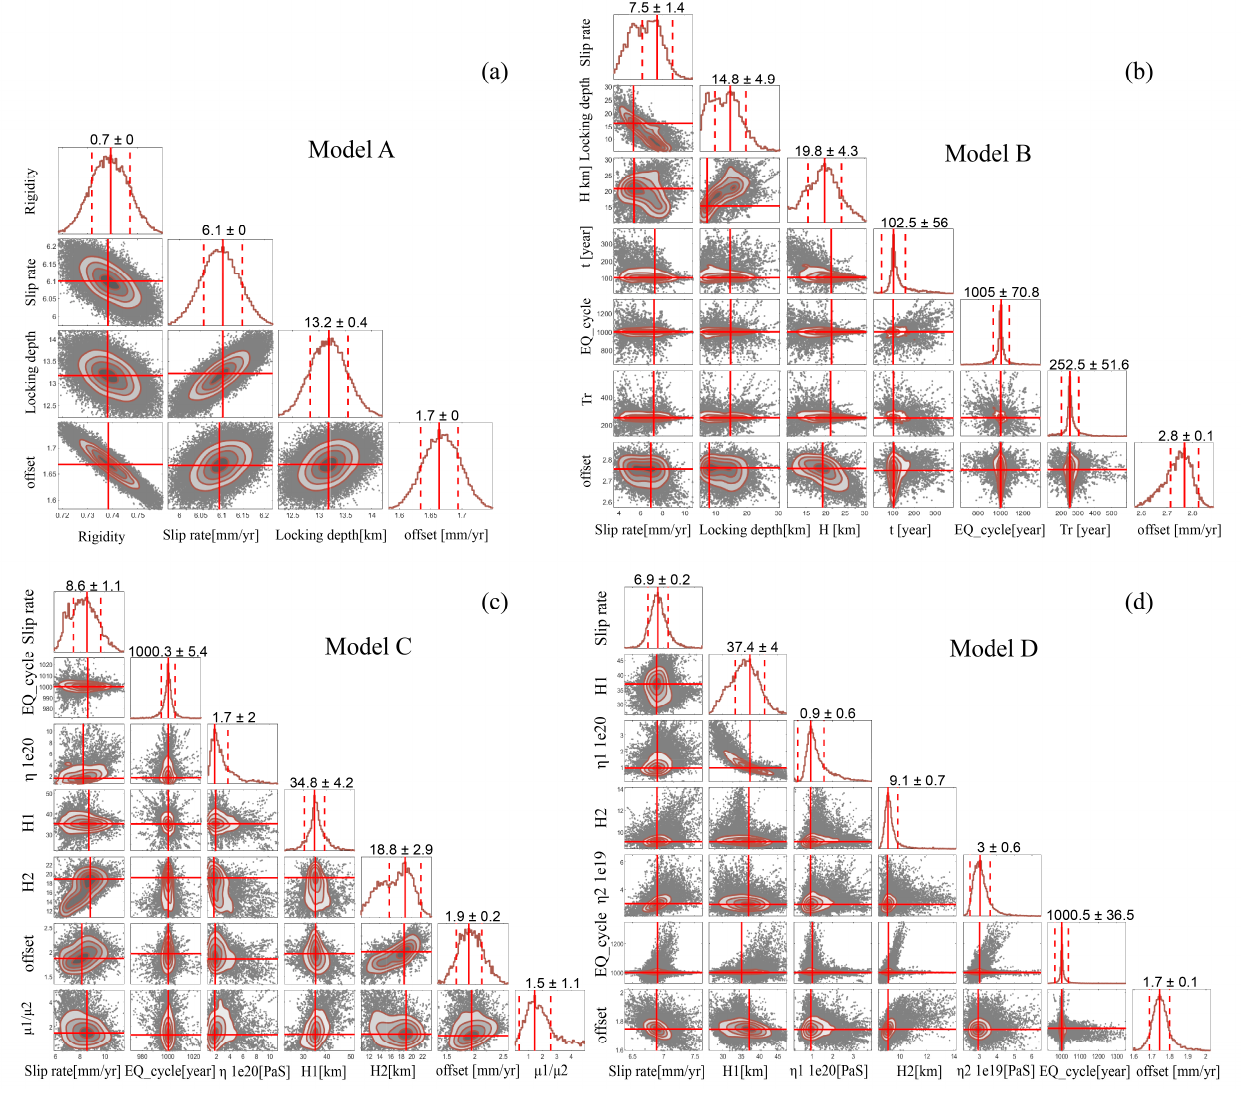
Figure 8. Inversion results of profile PQ using the MCMC method. Results of ( a ) Model A, ( b ) Model B, ( c ) Model C, and ( d ) Model D.